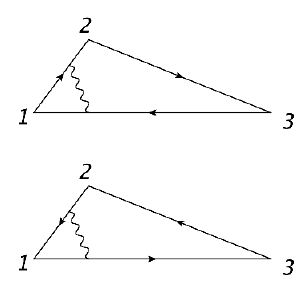
Figure 3 . Diagram IIA and IIB.